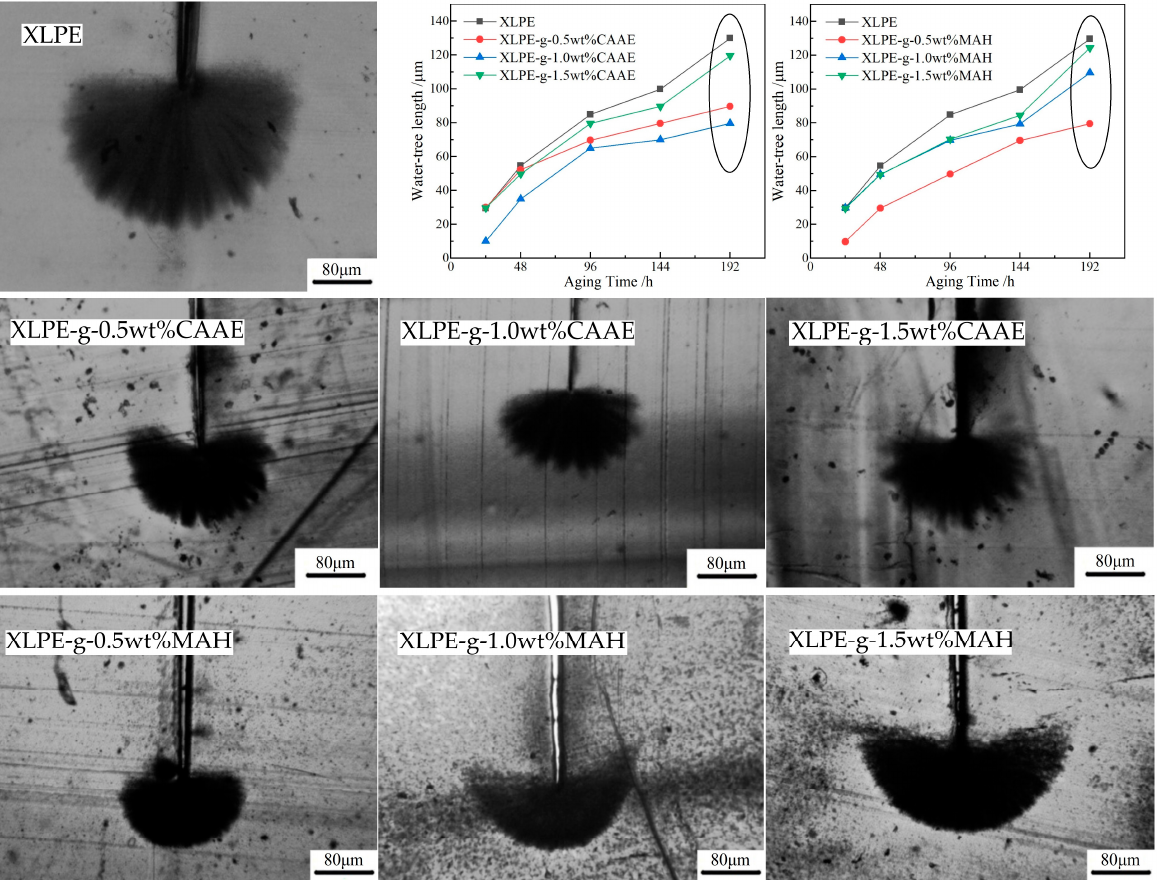
Figure 2. Water-tree morphology observed with optical microscopy for XLPE modified by grafting CAAE or MAH (image photos), and water-tree length versus aging time for XLPE-g-CAAE and XLPE-g-MAH compared with benchmark XLPE (top-right curve profiles).